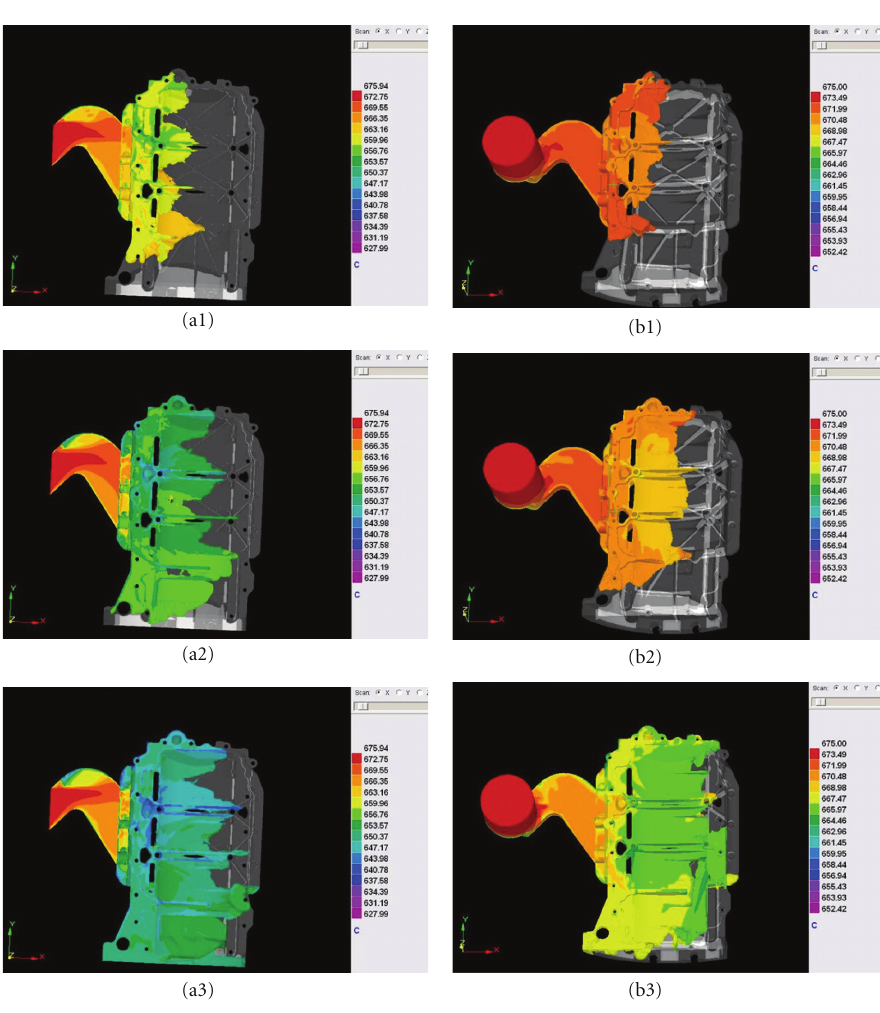
Figure 10: Flow pattern of melt with die temperature (a) 150 ◦ C and (b) 250 ◦ C in same time. Time a1 = b1, a2 = b2, and a3 = b3.